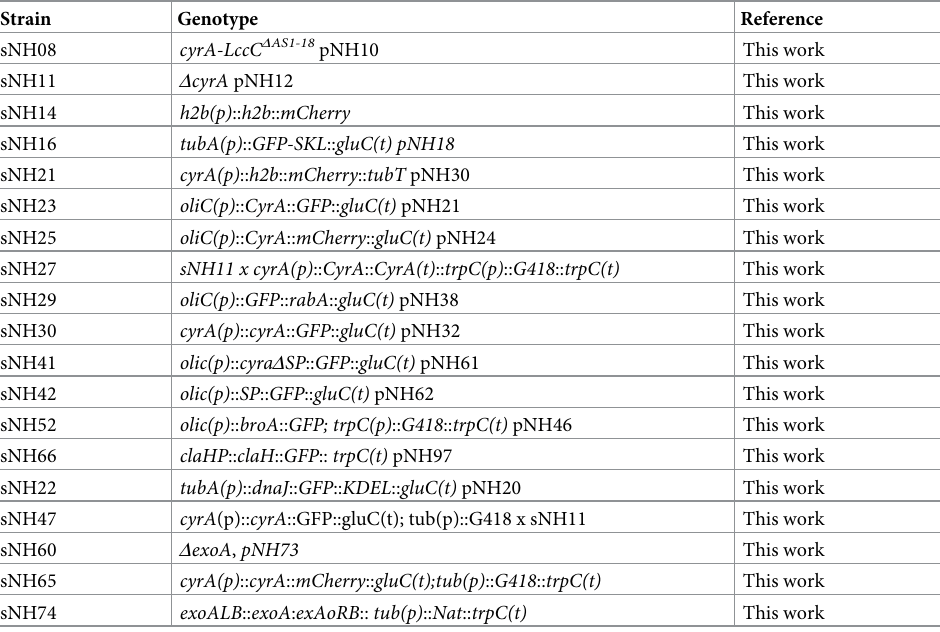
Table 2. D . flagrans strains used in this study. Strain